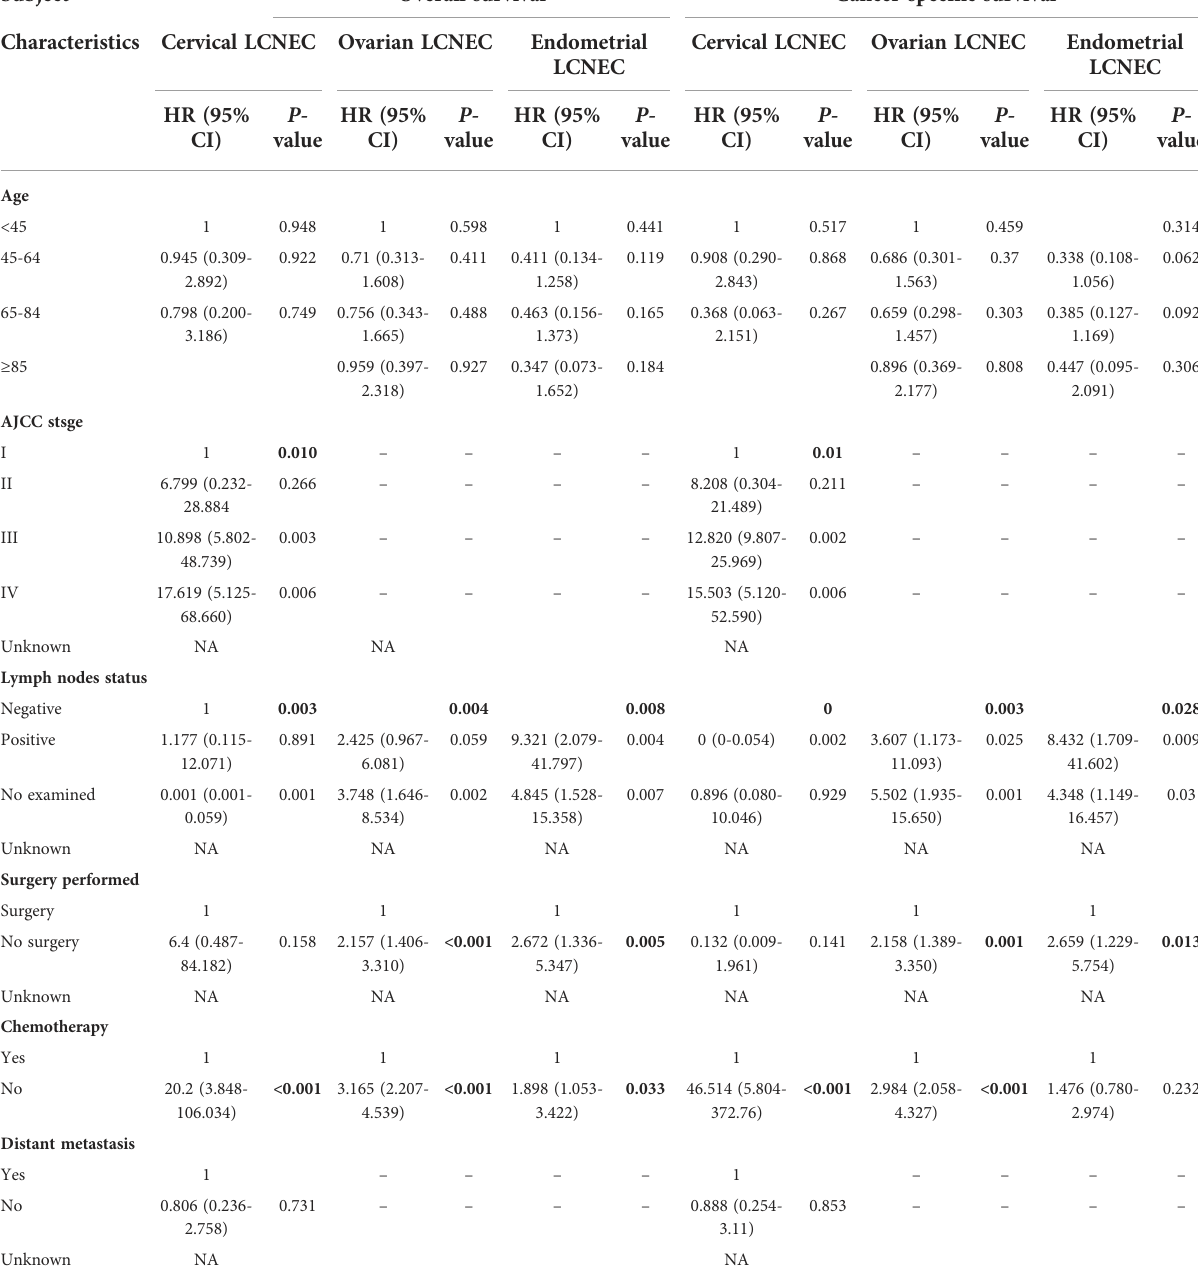
TABLE 3 Multivariate-Prognostic factors for gynecologic large-cell neuroendocrine carcinoma